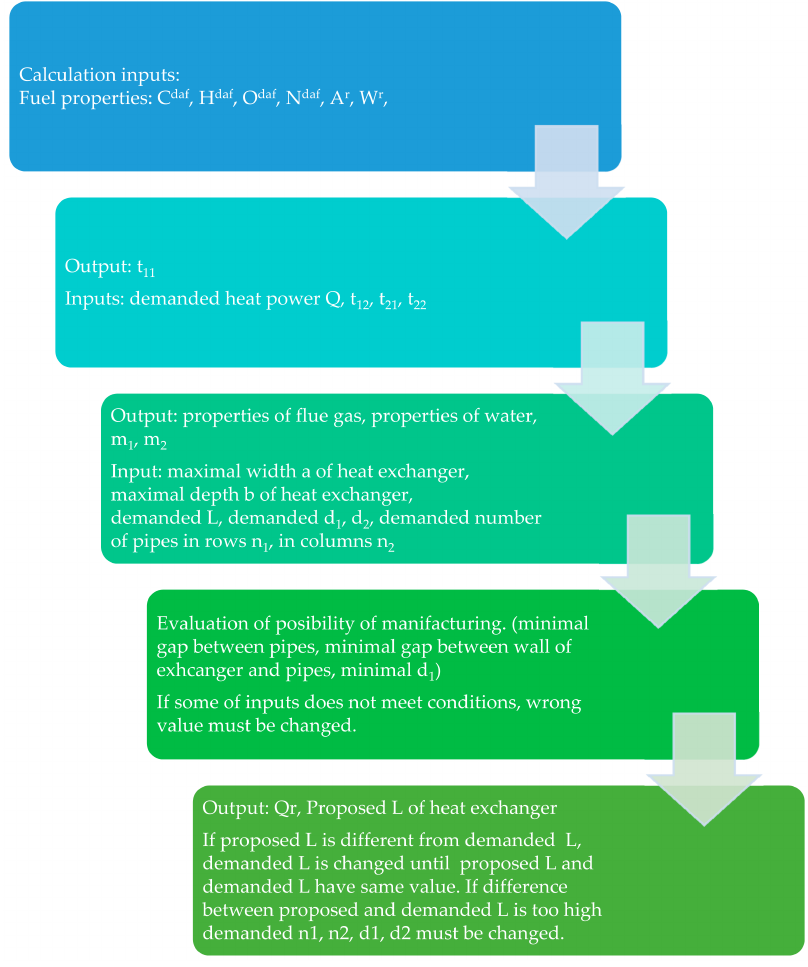
Figure 4. Scheme of calculations of heat exchanger’s